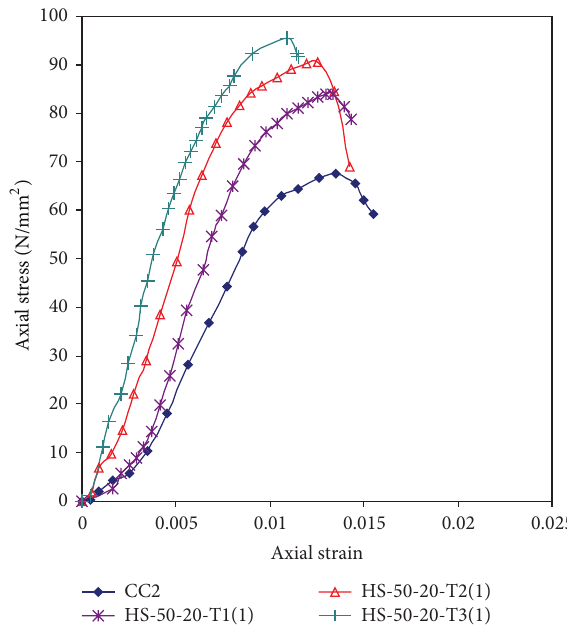
Figure 12: Axial stress-strain behaviour of columns HS-50-20—comparison.